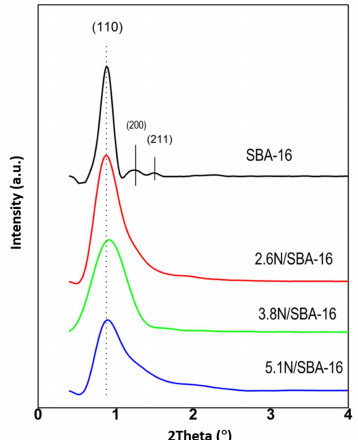
Figure 1. Small-angle X-ray di ff raction patterns of pure SBA-16 and amine-functionalized SBA-16